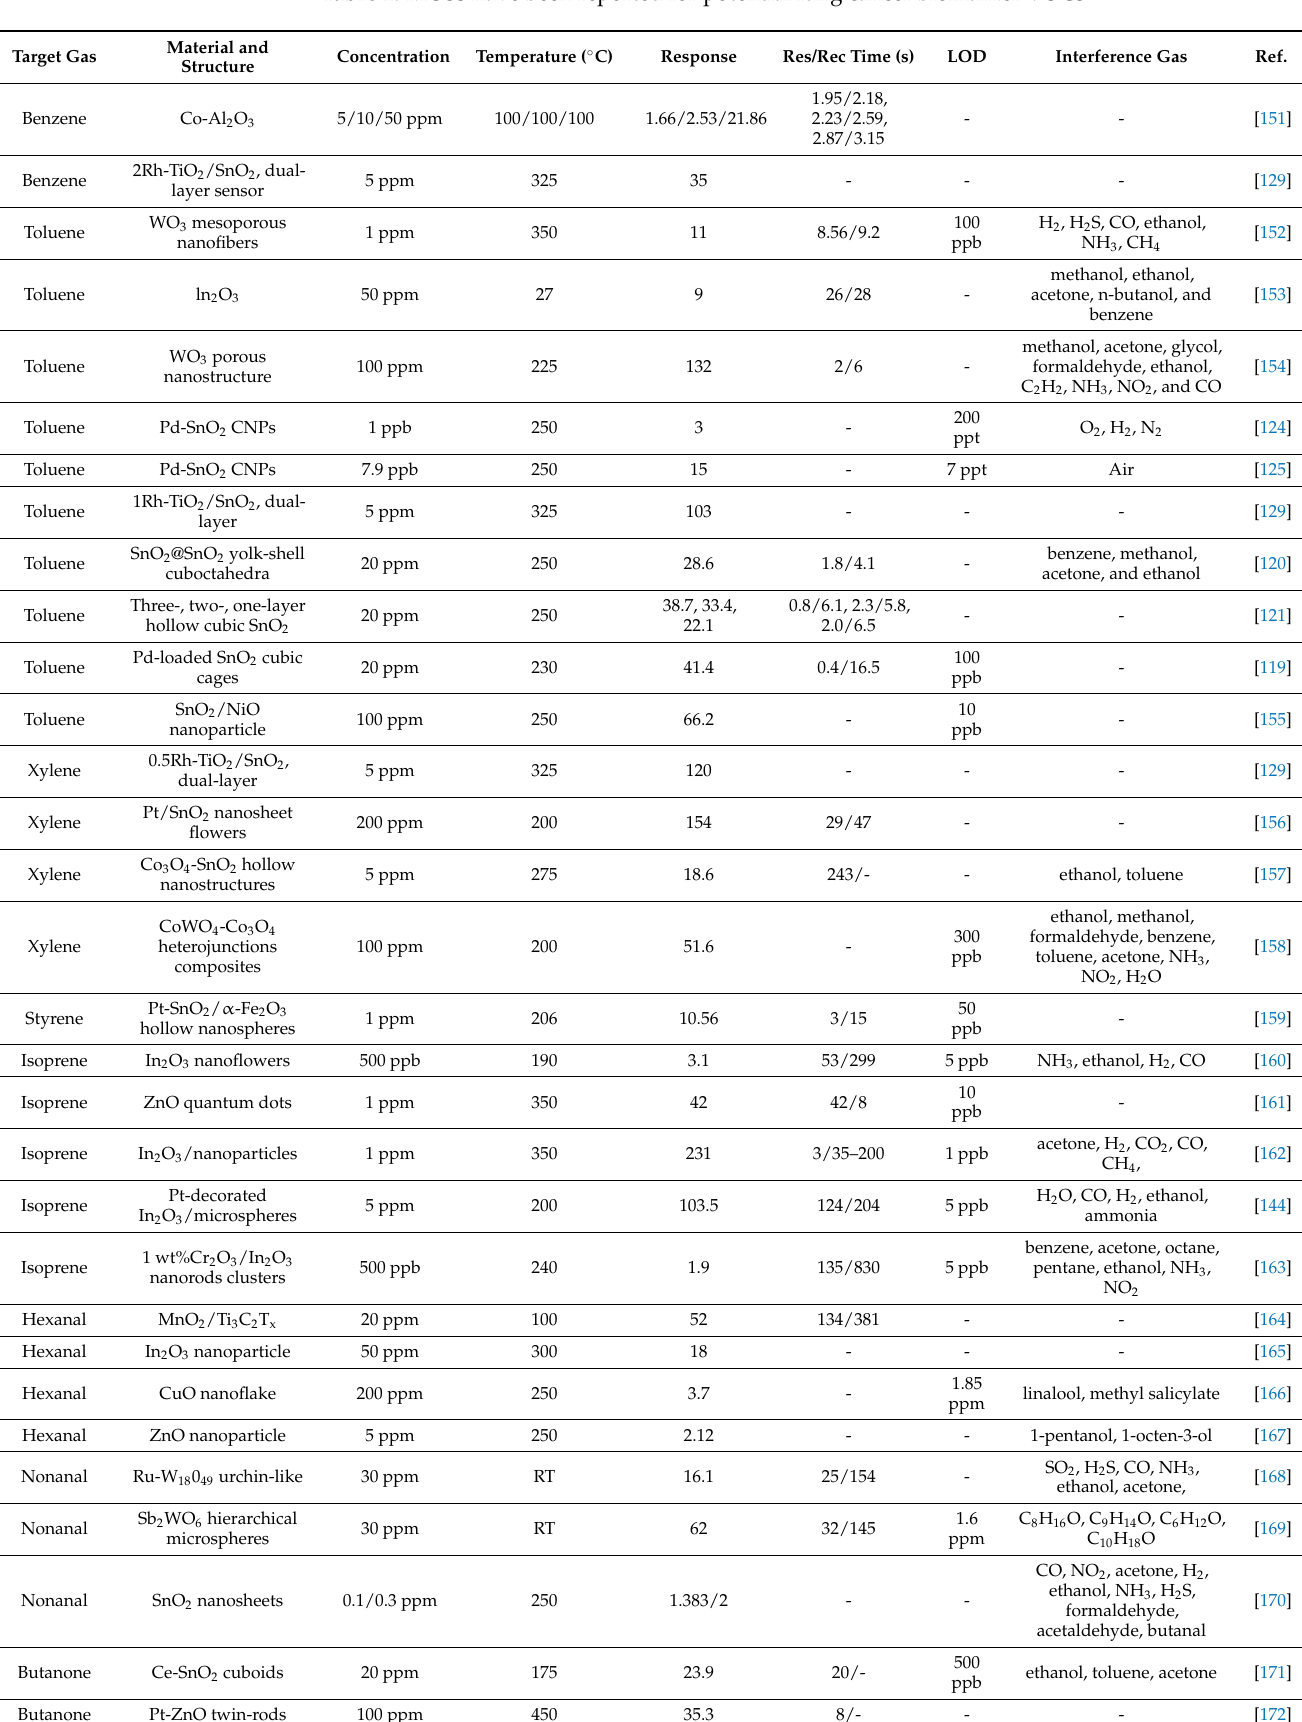
Table 1. MOSs have been reported for potential lung cancer biomarker